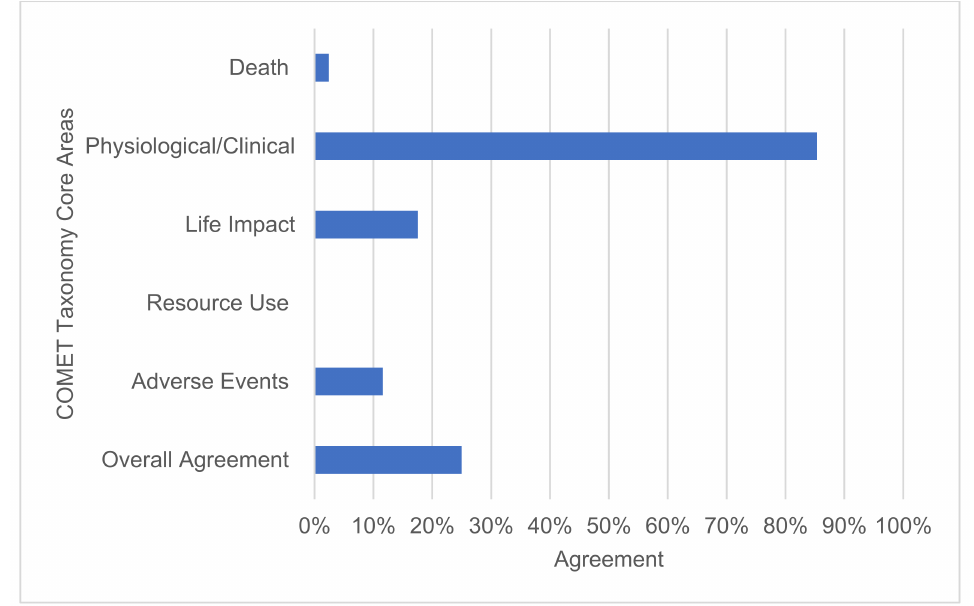
Figure 6. Overall agreement between outcomes reported by RCTs and their relevant COS for each COMET taxonomy core